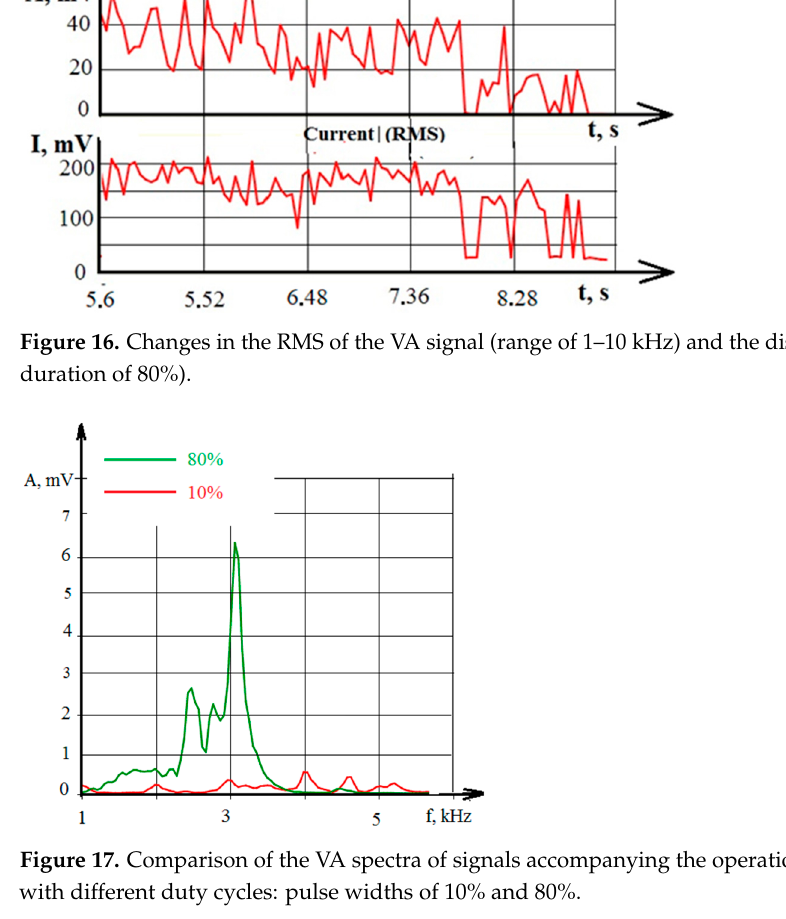
Figure 18. Dependence of the oscillation energy on the amount of valuable work.